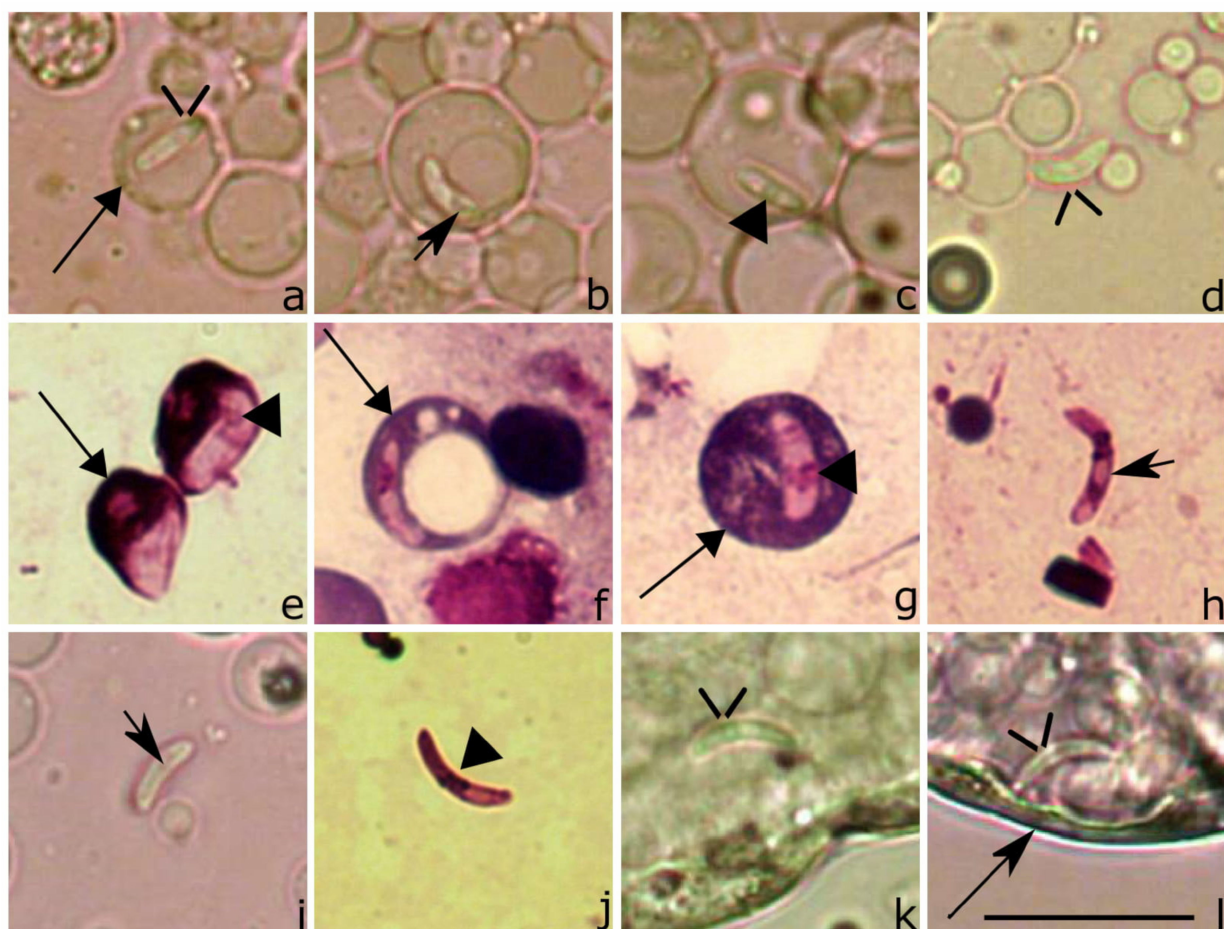
Figure 7. Sporozoites of Lankesterella kabeeni 18S rRNA lineages LanAcro1 ( a , b , d ) and LanAcro8 ( c , e – l ) in experimentally infected Aedes aegypti after blood meal on the naturally infected sedge warblers Acrocephalus schoenobaenus . The images show sporozoites in wet preparation ( a – d , i , k , l ) and methanol-fixed and Giemsa-stained preparation ( e – h , j ). Sporozoites inside mosquito haemocytes ( a – c , e – g ); they were also seen located free after the midgut was crashed ( d , h – j ) and inside mosquito midgut ( k , l ). Triangle, parasite nucleus. Short, barbed arrow, vacuole-like structure. Simple wide arrowheads, sporozoites. Long barbed arrow, basal lamina. Long triangle arrow, haemocytes. Scale bar: 10 µ